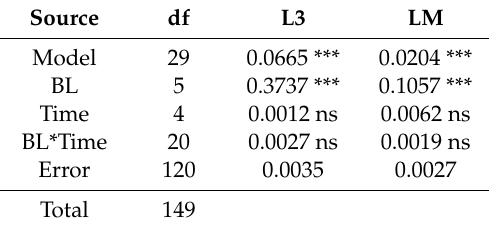
Figure 1. E ff ect of light on vanilla orchid chloroplast movement and gene expression patterns of phototropins. Slit assay showed that vanilla orchid chloroplast movement is dependent on blue light. Young leaves (L3) were dark-adapted for 4 h and then exposed overnight to monochromic LED blue light at 50 µ mol m − 2 s − 1 ( a ) and red light at 50 µ mol m − 2 s − 1 ( b ), respectively. Blue and red arrows indicate the leaf area exposure to blue or red light for slit assay chloroplast movement. Scale bar, 1 cm ( a,b ). ( c ) SPAD assay chloroplast movement of young vanilla leaves (L3) in response to various blue light intensities. ( d ) Chloroplast movement of mature vanilla leaves (LM). Quantitative RT-PCR indicated the gene expression patterns of phot1 and phot2 in the dark and under BL5 and BL100, respectively, in young leaves (L3) ( e ) and mature leaves (LM) ( f ). Error bars represent the standard error of the mean ( n = 3) ( c – f ). Table 1. ANOVA shows the mean square of relative Soil Plant Analysis Development (SPAD) data of young (L3) and mature leaves (LM) of vanilla orchid exposure to various blue light intensity and di ff erent time courses.